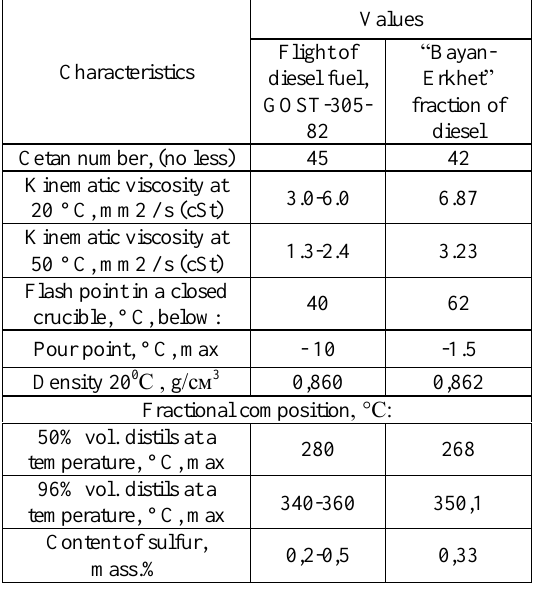
Table 8. Characteristics of the diesel fraction (200 - 350 ° C) of liquid products of thermal processing of bituminous